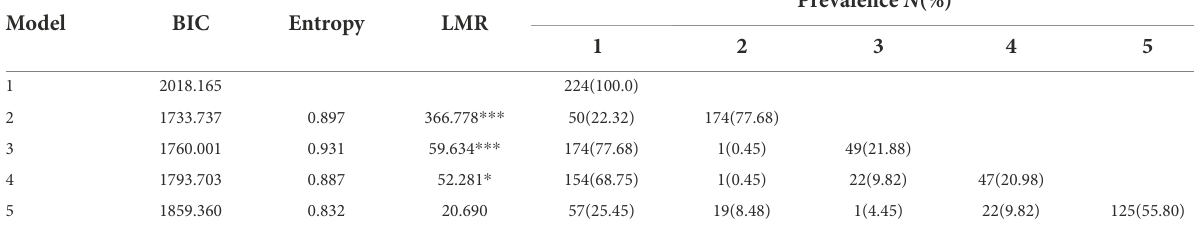
TABLE 1 Model fit statistics for each of the fitted latent class analysis models.